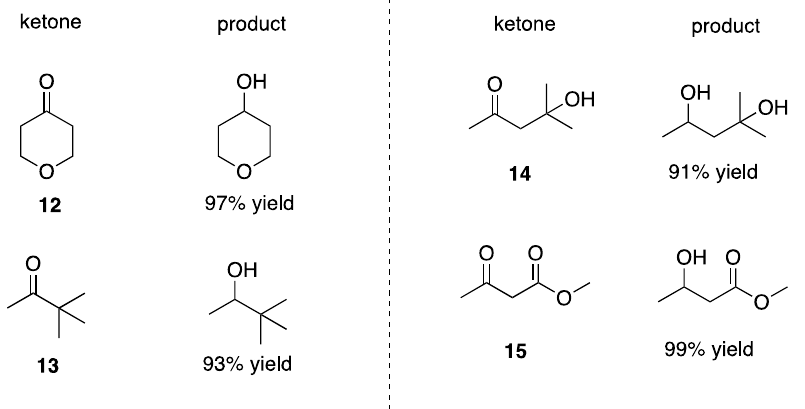
Figure 4. Reduction of ketones 12 – 15 to the corresponding alcohols. N 2 -saturated aqueous solutions of carbonyl compound (8.3 mM) cysteine (18.3 mM), pH adjusted to 10.6 at 42 ± 1 °C, were irradiated for 60 min. Yields by GC analysis based on products formation.